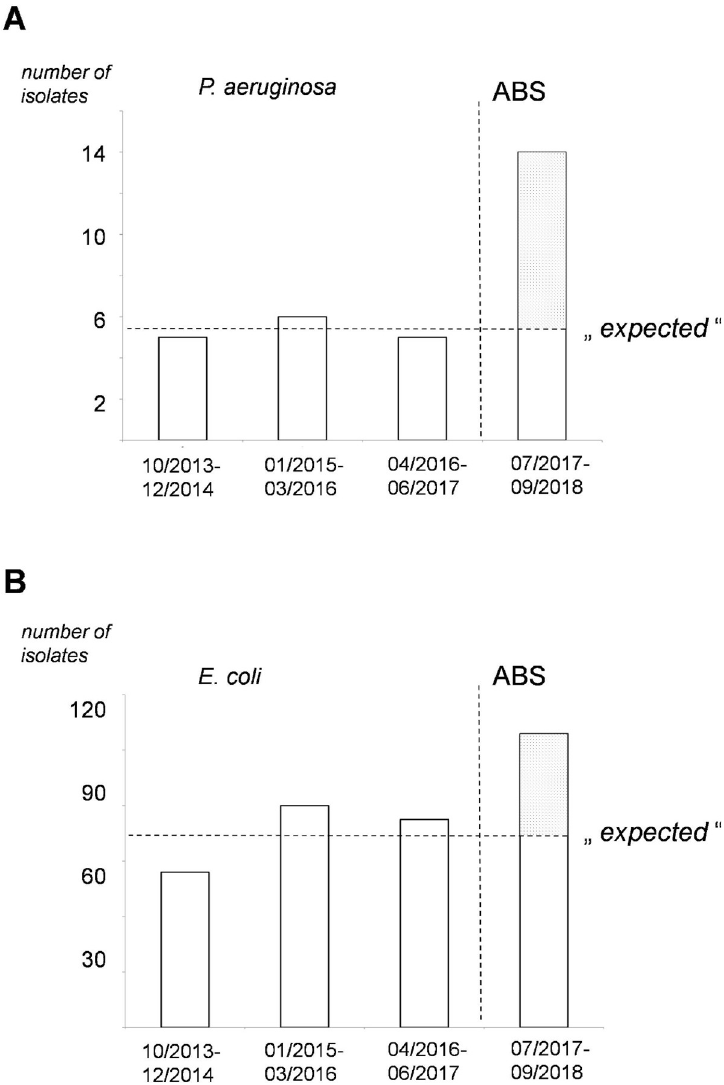
Fig 2. Expected and actually detected episodes of bacteraemia during the diagnostic ABS-period. Number of detected isolates of P . aeruginosa (A) and E . coli (B) before and after implementation of the diagnostic ABS bundle (vertical dotted line). Each bar represents a 15-month period. The horizontal dotted line indicates the expected number of isolates in the 15-month diagnostic ABS period based upon the means for the three 15-month periods